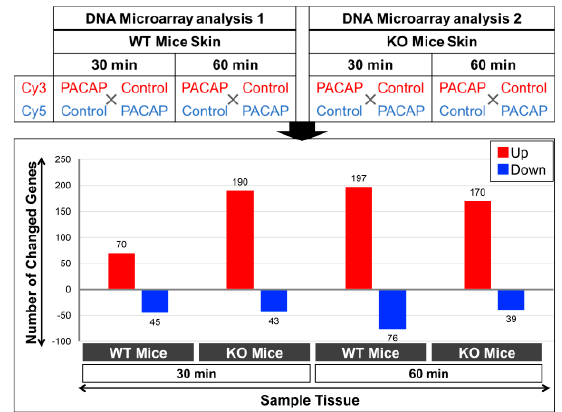
Figure 4. Differentially expressed genes in the WT mice and KO mice after the addition of PACAP at 30 and 60 min by DNA microarray analysis. Two DNA microarray chips were used for each sample condition, i.e., a dye ‐ swap approach was used to label one set of RNAs by Cy3 and the other by Cy5 for each control and PACAP sample, respectively, as detailed in the Materials and Methods section. A 4 × 44 ‐ K format slide containing 4 chips is illustrated for the current study. The histograms show the up (red) ‐ and down (blue) ‐ regulated gene ( ≧ / ≦ 2.0/0.5 ‐ fold) numbers in each examined tissue. The gene expression data are publicly available under the GEO series accession number GSE223124 (https://www.ncbi.nlm.nih.gov/geo/query/acc.cgi?acc=GSE223124; accessed on 19 February 2023).